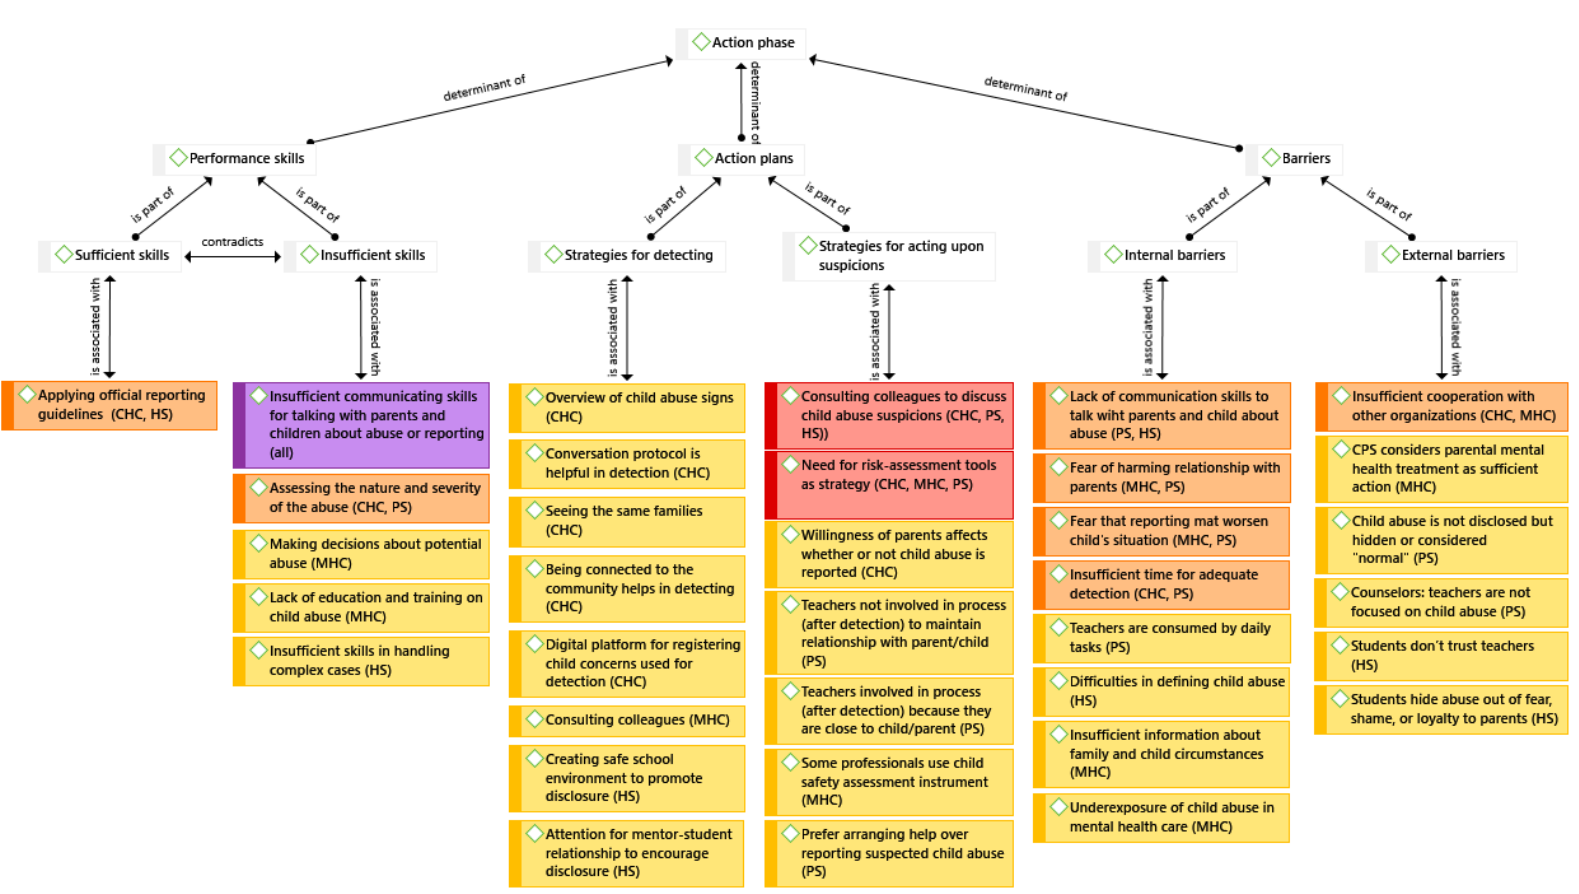
Figure 3. A concept map of the results as related to the action phase of the I-Change model. The labels on the second level refer to the determinants of the action phase, the labels on the third level refer to the key themes, and the labels on the fourth level refer to the subthemes. Subthemes with purple labels are relevant for all groups of professionals, subthemes with red labels are relevant for three groups, subthemes with orange labels for two groups, and subthemes with yellow subtheme for one group of professionals. The specific groups of professionals for which the subthemes were applicable, are presented in parentheses. CHC = child health care professionals; MHC = mental health care professionals; PS = primary school professionals; HS = high school professionals.